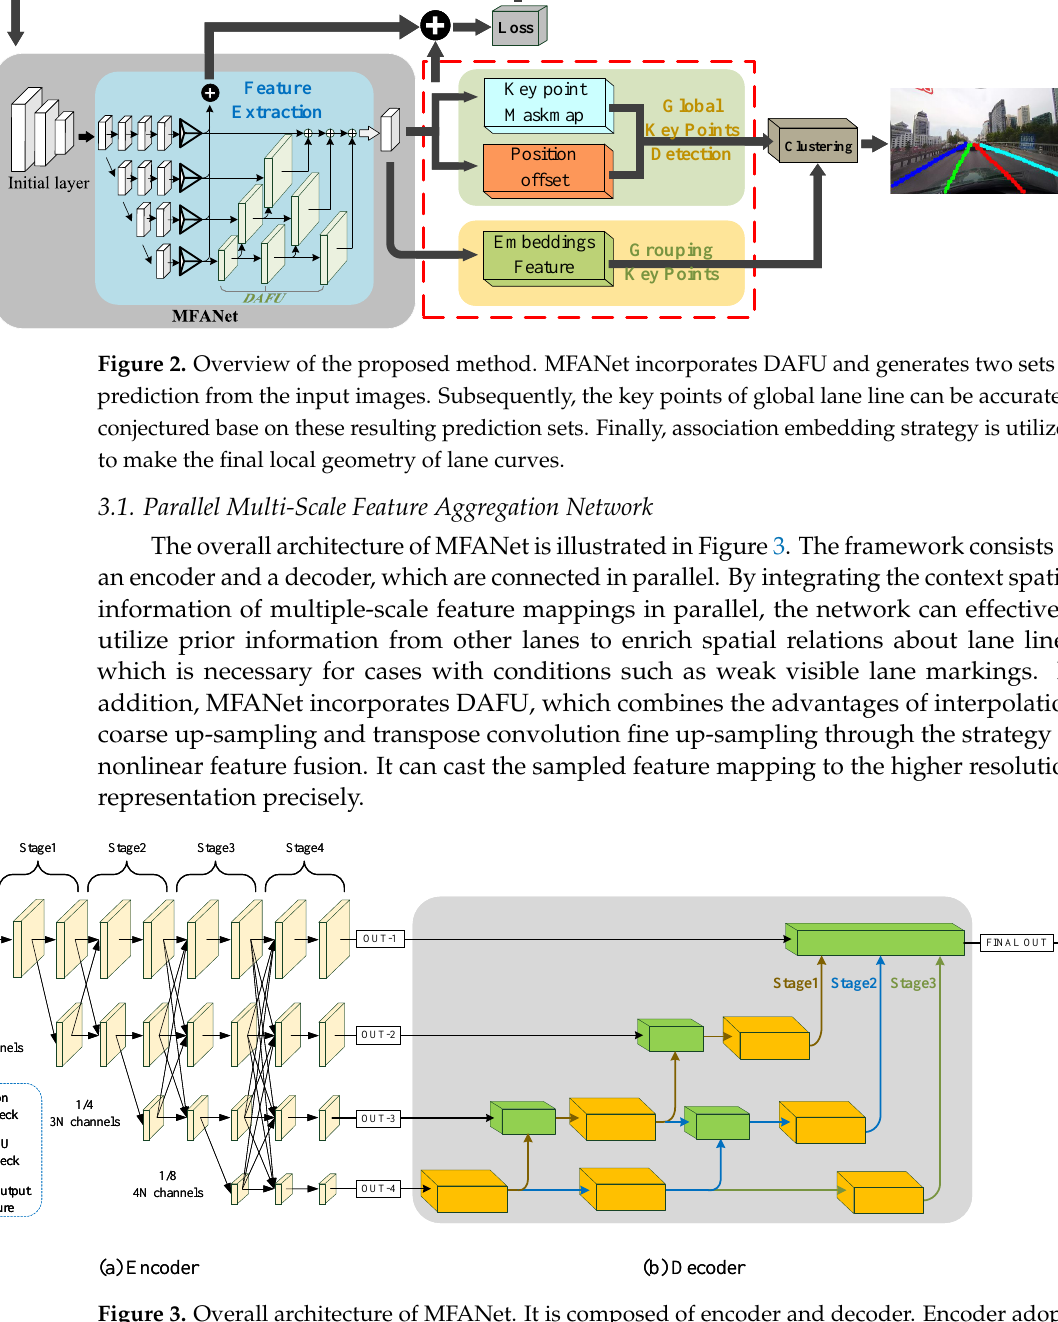
Figure 3. Overall architecture of MFANet. It is composed of encoder and decoder. Encoder adopts the backbone of HRNet [27] for more efficient multi-scale feature extraction. It consists of four stages of multi-scale parallel subnets. Decoder consists of DAFU, which recovers multi-scale features to the original size